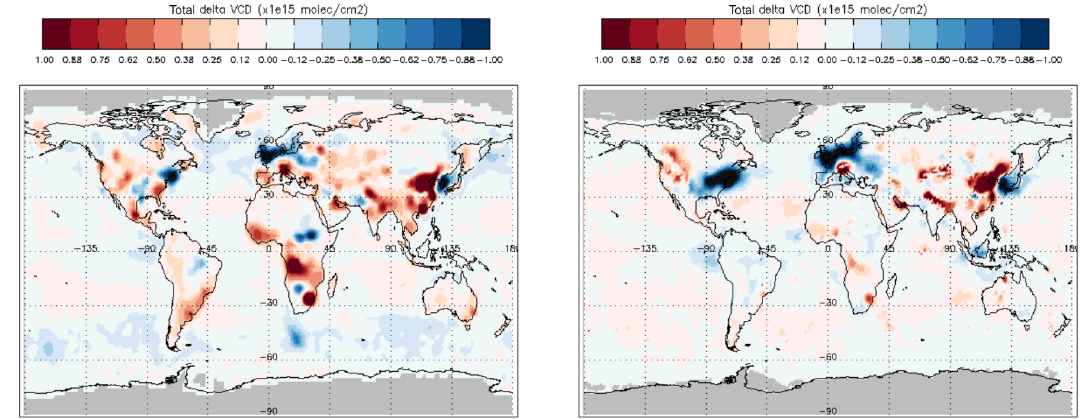
Figure 14. Total tropospheric NO 2 column differences (OMI–TM4) in clear (left) and cloudy (right) conditions for the year